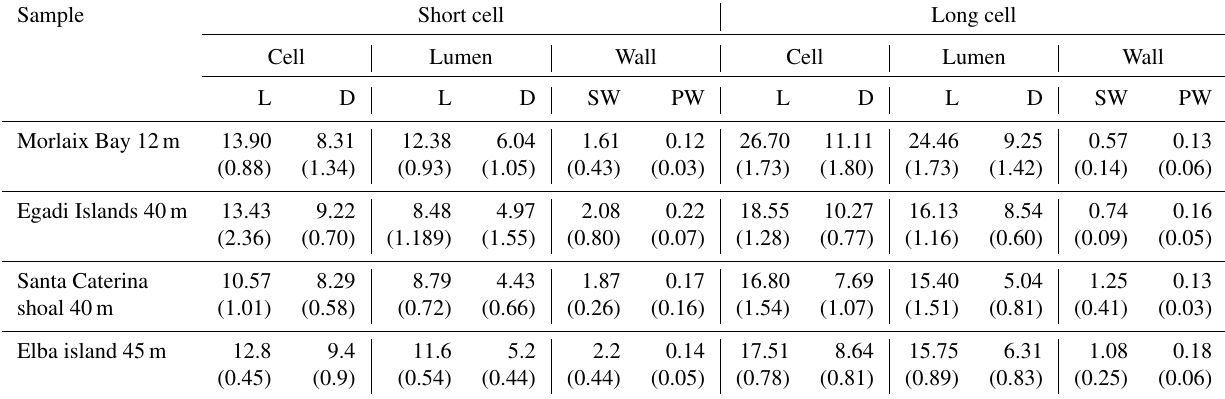
Figure 2. Cell measurements: (a) cell wall length (red) and diameter (blue); (b) lumen length (yellow) and lumen diameter (purple); (c) SW thickness of adjacent cells (orange); PW thickness of adjacent cells (green). Table 2. Morphometry of short and long cells and lumens and wall thickness measured in longitudinal section (PW = primary wall, SW = secondary wall) with the indication of length (L) and diameter (D) (µm). Standard deviation in brackets.